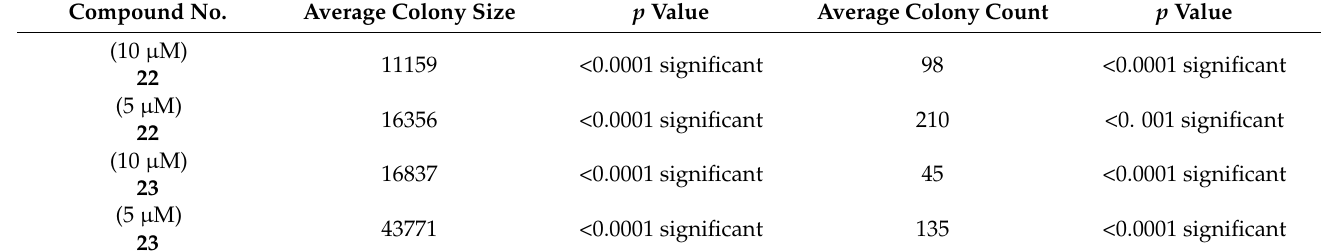
Table 4. Effect of treatment on A549 anchorage-independent cell growth.